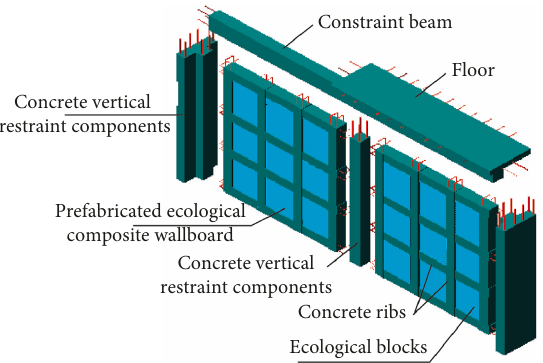
Figure 1: Fabricated composite wall.